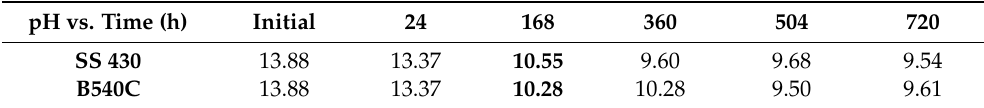
Table 3. Change in time of pH of chloride-containing (5 g L − 1 NaCl) cement extract solution, during the immersion of SS 430 and carbon steel B450C for 720 h (30